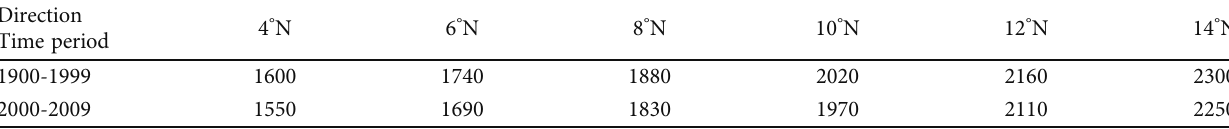
Table 5: Annual solar radiation distribution (W/m 2 ) at di ff erent degrees from 4 ° N to 14 ° N.